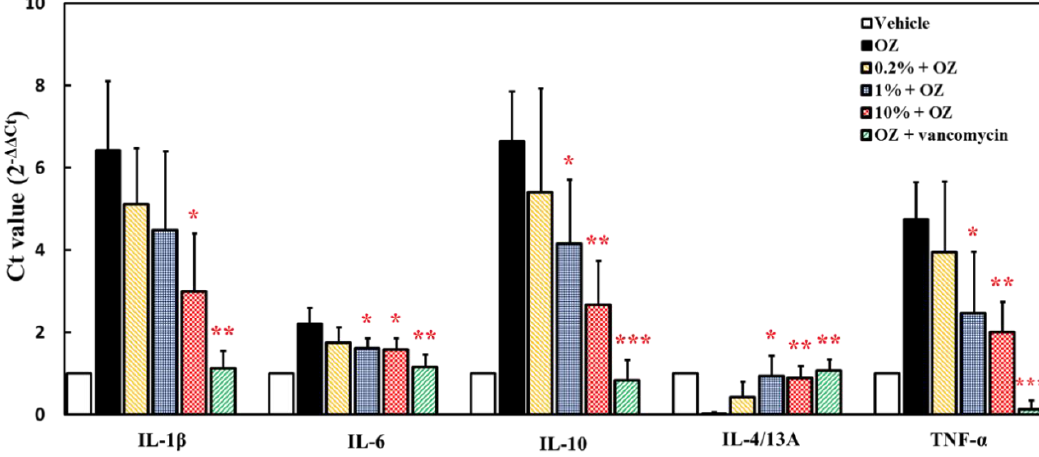
Figure 5. Effect of ACEW supplementation on gene expression of inflammation-associated cytokines in zebrafish under the intestinal stimulation by oxazolone in prevention mode experiment. Each group of 10 adult zebrafish was fed with specified diet for 30 days before the experiment, and then 0.2% oxazolone were intrarectally instilled to induce acute enteritis. Significant difference of gene expression between the ACEW supplemented diet group and the control diet group (group OZ without ACEW addition) was denoted as * p < 0.05, ** p < 0.01, and *** p < 0.001.